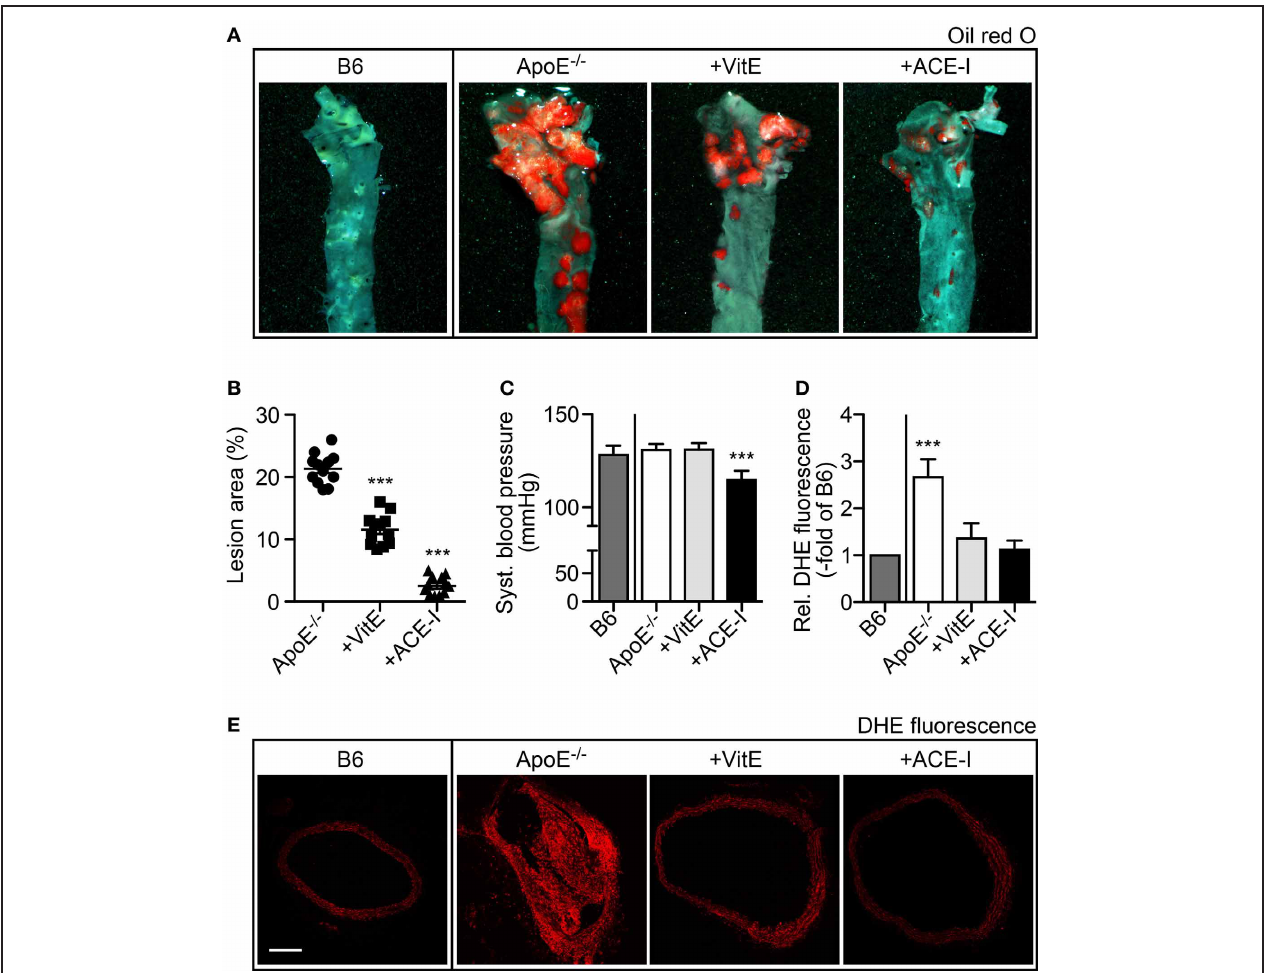
mice/group; ∗∗∗ P < 0 . 0001 vs. ApoE − / − ). (C) Systolic blood pressure of different treatment groups of mice ( ± s.d.; n = 5 mice/group; ∗∗∗ P < 0 . 0001 vs. B6). (D) Detection of aortic ROS in situ by dihydroethidium (DHE) staining of aortic sections and quantitative assessment of relative fluorescence levels generated by reaction of dihydroethidium with superoxide ( ± s.d.; n = 5 mice/group; ∗∗∗ P = 0 . 0006 vs. B6). (E) Representative DHE-stained aortic sections from a 34 week-old untreated B6 control mouse, a 34 week-old untreated ApoE − / − mouse, a vitamin E-treated ApoE − / − mouse ( + VitE), and an ACE-inhibitor-treated ApoE − / − mouse ( + ACE-I); bar 200 μ